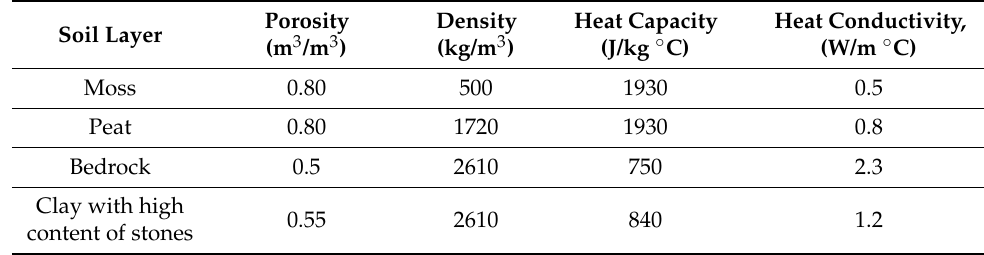
Table 4. Soil layer physical